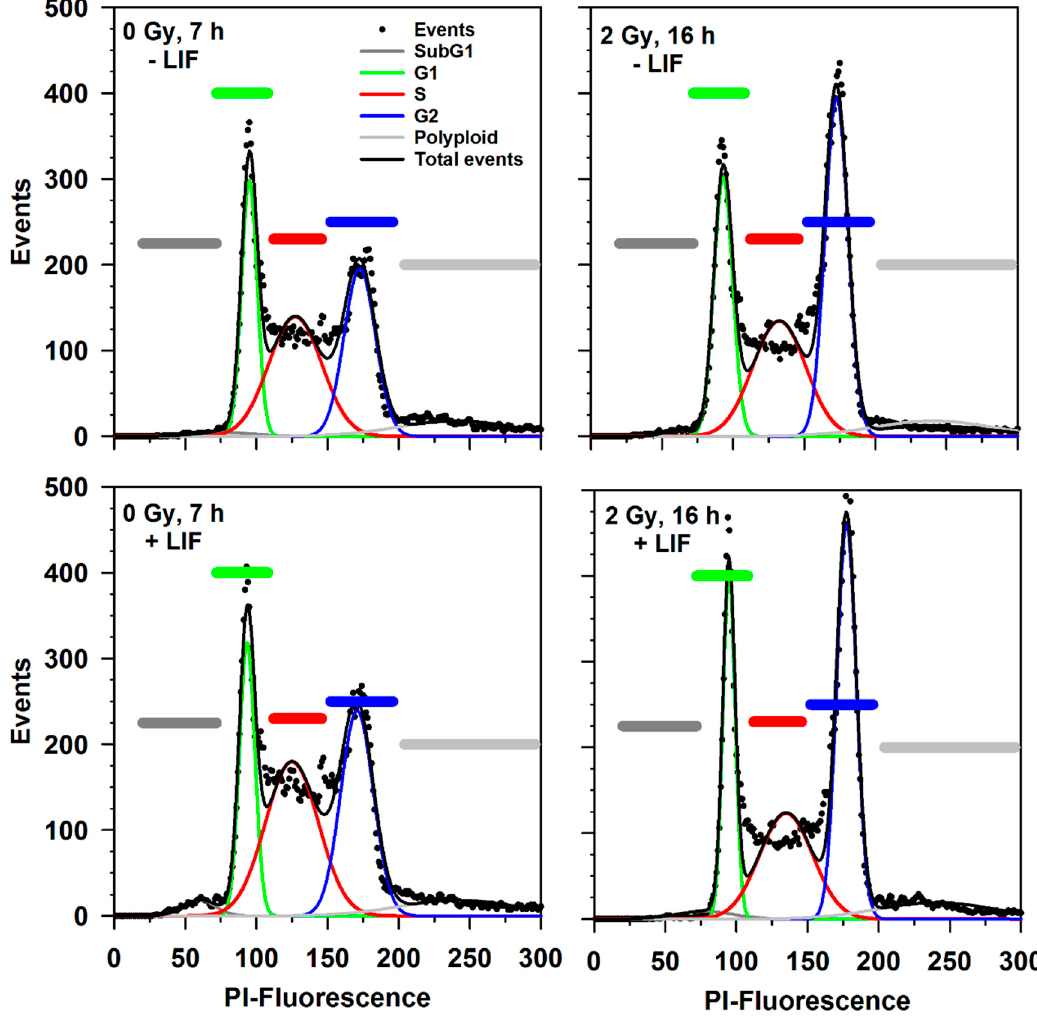
Figure 3. Determination of cell cycle progression after X-ray exposure (0 Gy and 2 Gy). The identification of the subpopulations with sub-G1, G1, S and G2 phase or polyploid DNA content is shown in exemplary propidium iodide (PI) fluorescence histograms. mESCs were incubated in the absence (-LIF) or presence of LIF ( + LIF) for 7 h (left) or 16 h (right). Cellular DNA was stained with propidium iodide, RNA was digested by incubation with RNase. Propidium iodide fluorescence was determined by flow cytometry.